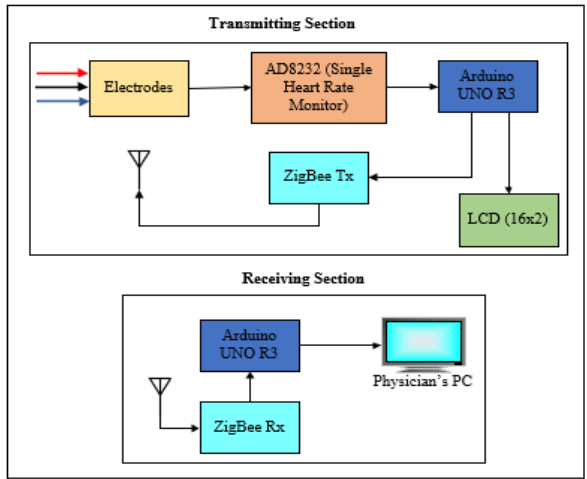
Figure 1. The wireless portable electrocardiograph monitoring